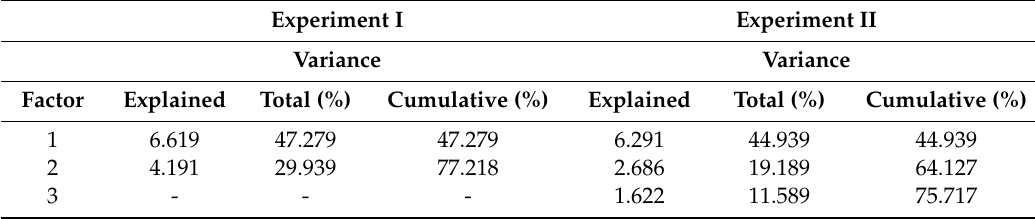
Table 13. Explained, total, and cumulative variance in each factor of the PCA for analyzed variables of soybean plants submitted to water deficit, xenobiotic, and antioxidant agent